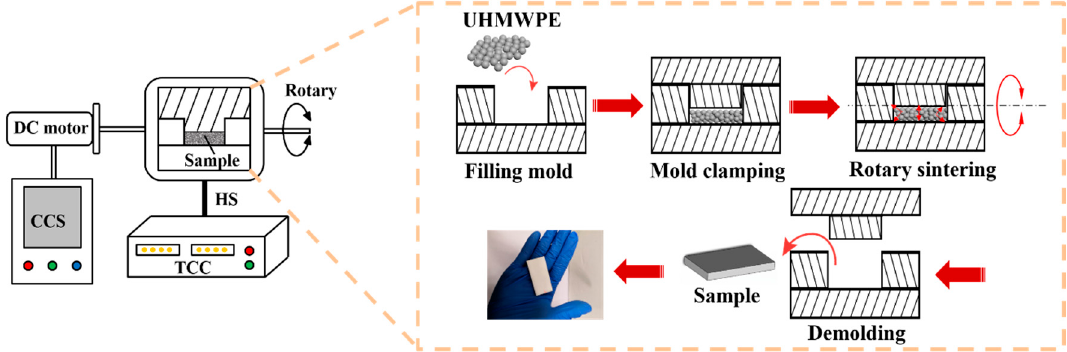
Figure 1. Schematic diagrams of the dynamic rotary sintering device and the fabrication procedure of